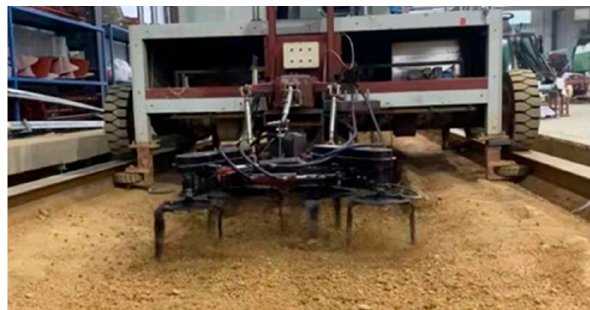
Figure 12. Experimental test process